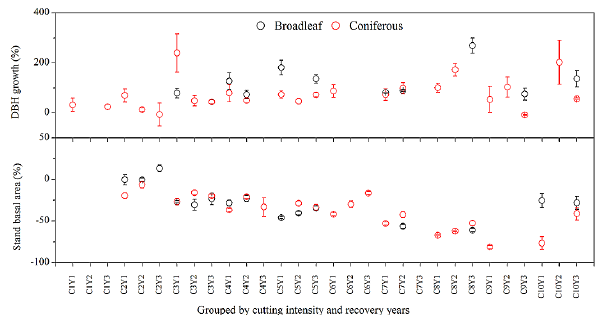
Fig. 2. Scatterplots of the mean relative changes (%) of DBH growth and stand basal area for different forest types (i.e., broadleaf and coniferous) grouped by cutting intensity and recovery years when there are three or more observations for the group. The error bars are the standard deviation (SD). C1 to C10 represent the cutting intensity levels ranging from 0–10 to 90–100 with 10% intervals. Y1, Y2, and Y3 indicate the number of recovery years of 0–5, 5–10, and > 10yr., respectively.